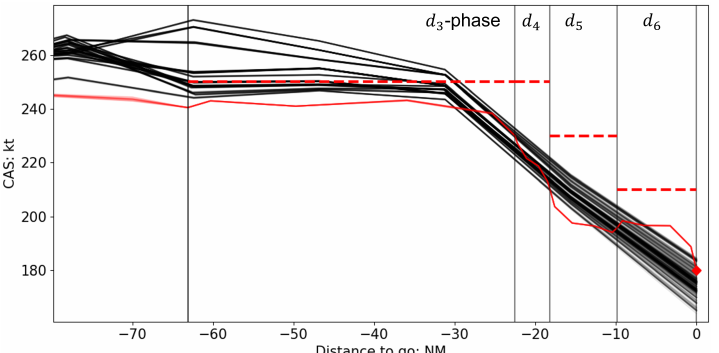
Figure 10. Total operational costs for each weather scenario (with C I = 30 kg/min, RTA not imposed). The box plots show the ranges of costs of the inappropriately-controlled trajectories for the corresponding weather scenarios, and their mean values are depicted with the green triangles. Each box plot is based on the costs of N w − 1 = 20 inappropriately-controlled trajectories. The red dots show the costs for the robust trajectory.